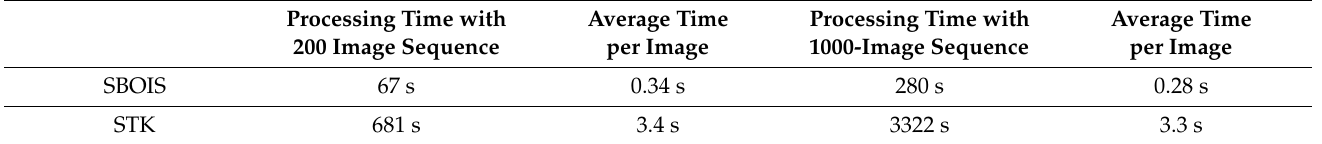
Table 3. Computation Time